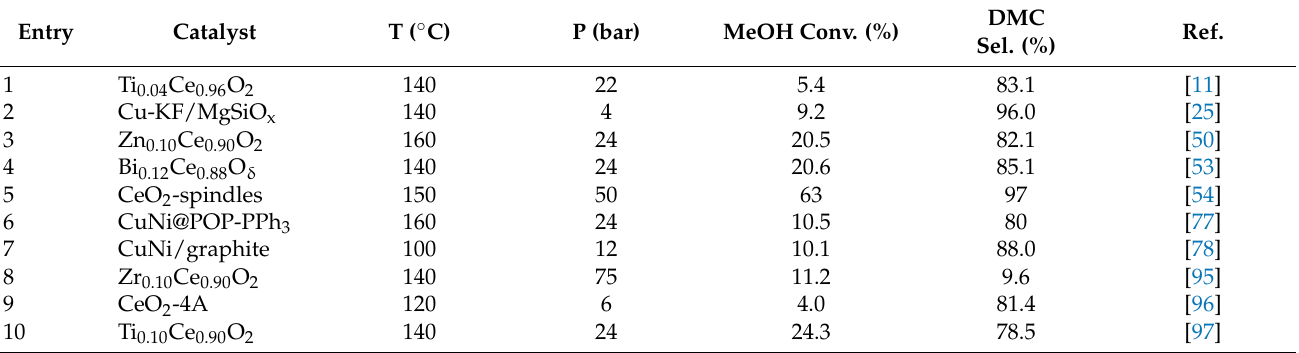
Table 1. Summary of reaction conditions and catalytic performances in the direct green DMC